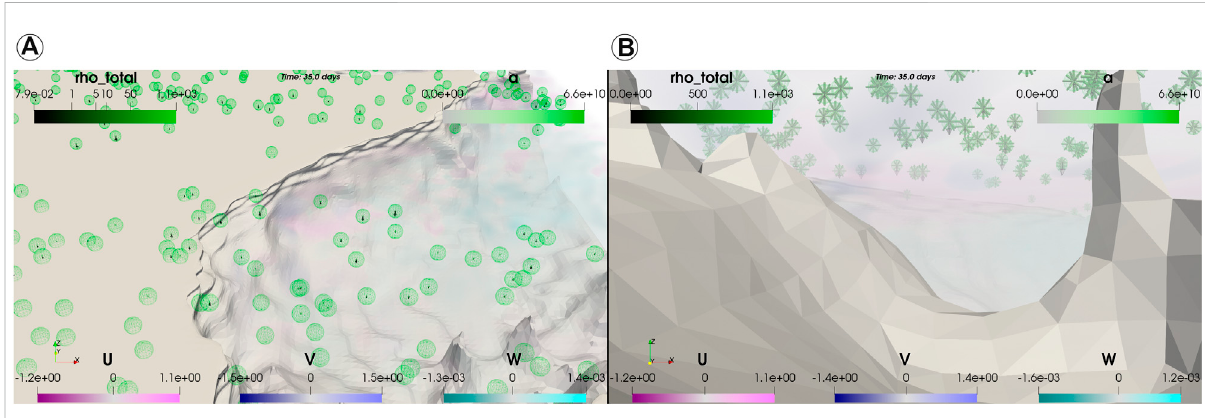
FIGURE 15 Visualisation of algae-accumulating particles inthe ocean near an equatorial plateau. The overview provides an impression ofparticlesizes and fl oating- or sinking behavior through the arrow-incorporating complex glyphs (A) . The Eulerian velocities are clearly visible in a submerged view, as well as the core seasonal glyph type (B)